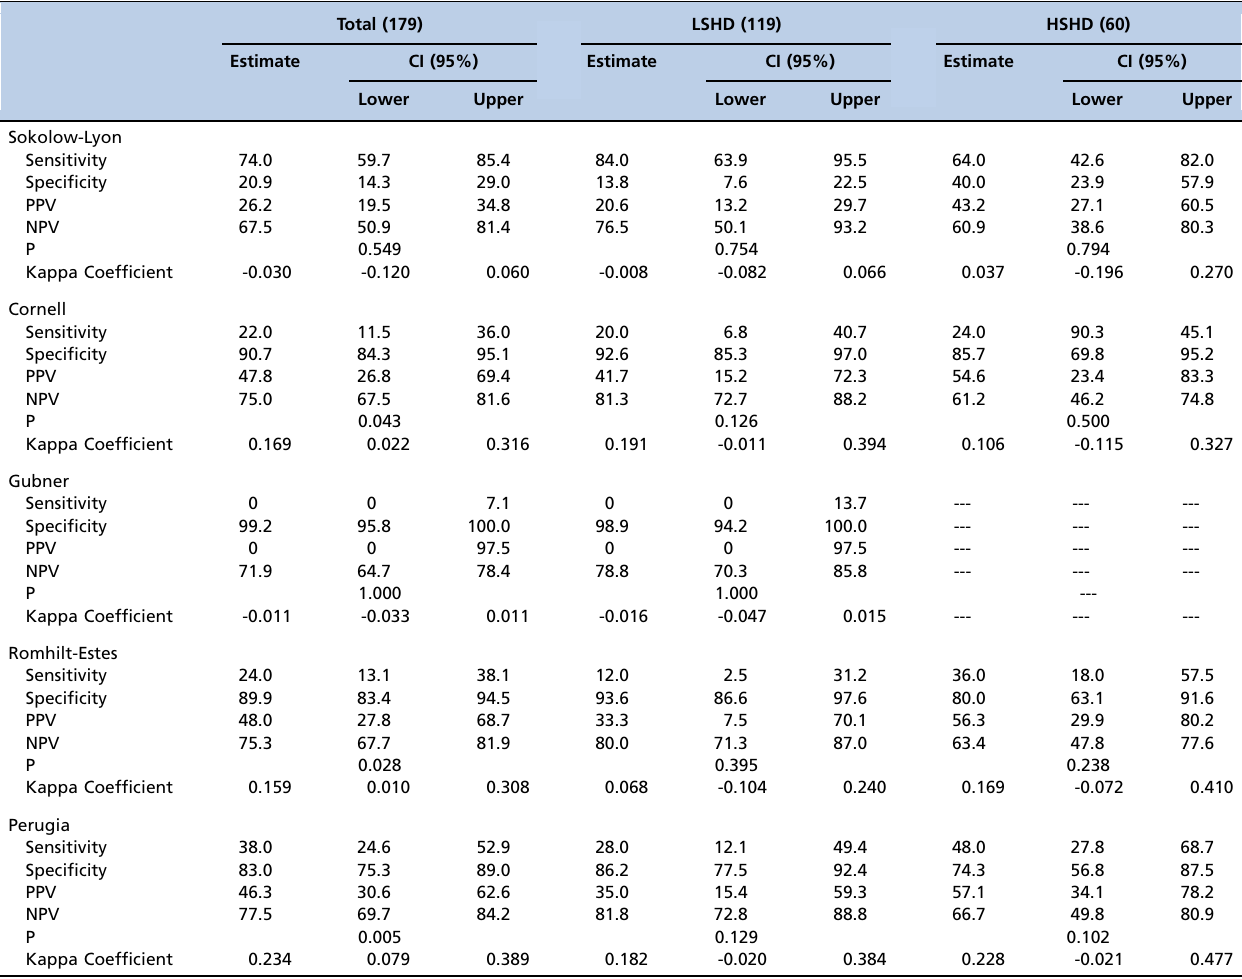
Table 5 - LVMI or RWT or LVDDI and/or Septum and/or PWT x Electrocardiogram